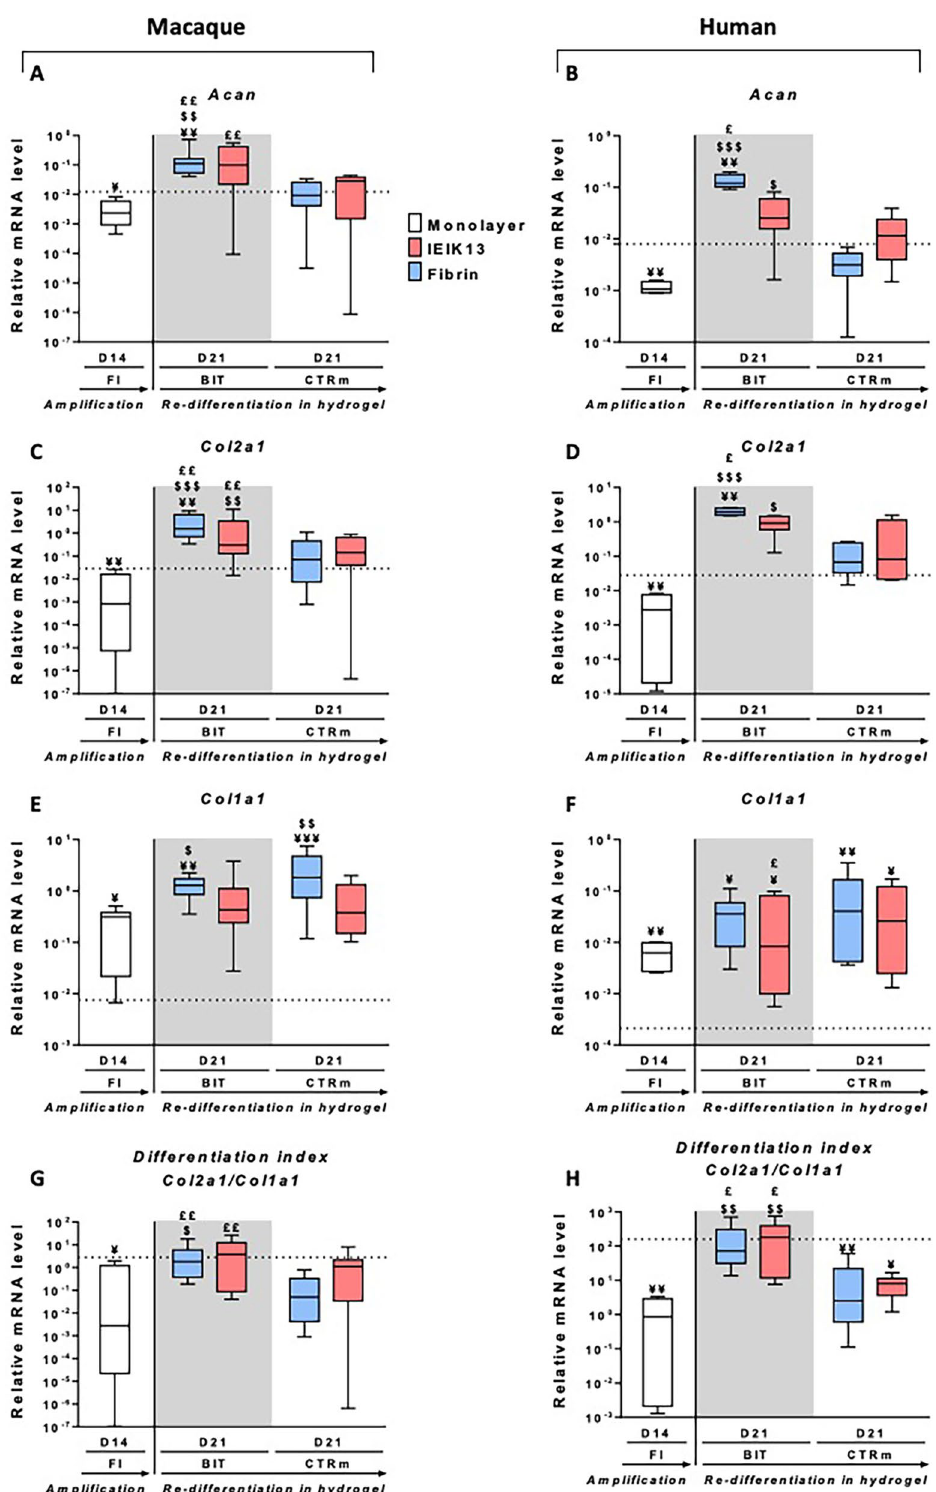
Figure 1. Effect of culture conditions on the mRNA steady-state levels of specific markers, as indicated, in macaque and human chondrocytes. After extraction, chondrocytes were amplified on plastic for 14 days (D14) in the presence of FGF-2 and insulin (FI). Then, they were seeded in fibrin or IEIK13 hydrogel and cultivated for 21 days (D21) in control medium (CTRm) or in medium containing BMP-2, insulin and T3 (BIT). Data are presented as box plots (median, quartiles, extreme values). The horizontal dotted lines correspond to mRNA levels of chondrocytes 48 h after their isolation time (values reported as medians). ( A , B ) Relative mRNA expression of Acan . ( C , D ) Relative mRNA expression of Col2a1 . ( E , F ) Relative mRNA expression of Col1a1 . (G,H) Col2a1:Col1a1 mRNA ratio. The results shown were obtained with chondrocytes isolated from 6 human donors and 9 animals. (¥: significant effects vs. 48 h chondrocytes, as determined using the Mann–Whitney test; $: significant effects vs. D14 chondrocytes amplified with FI, as determined using the Kruskal–Wallis test; £: significant effects vs. D21 chondrocytes cultivated in control medium, as determined using the Wilcoxon test; ¥, $, £, p < 0.05; ¥¥, $$, ££, p < 0.01; ¥¥¥, $$$, £££, p <